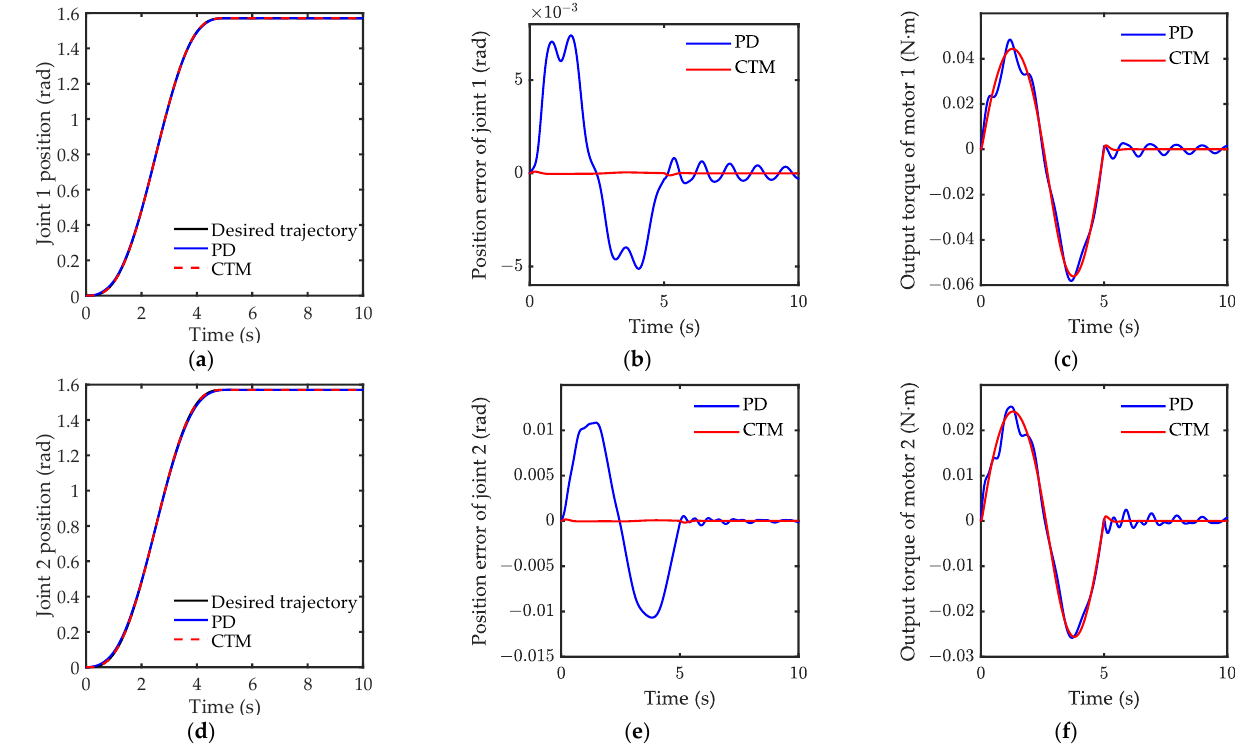
Figure 14. Simulation result of motion case 1: ( a ) joint 1 position; ( b ) position error of joint 1; ( c ) output torque of motor 1; ( d ) joint 2 position; ( e ) position error of joint 2; ( f ) output torque of motor 2.